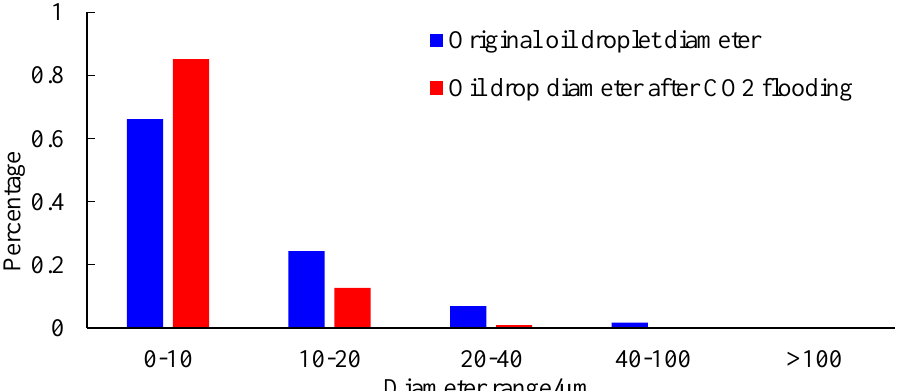
Figure 23. Distribution of the residual oil drop diameter of the Y29 – 100 core.